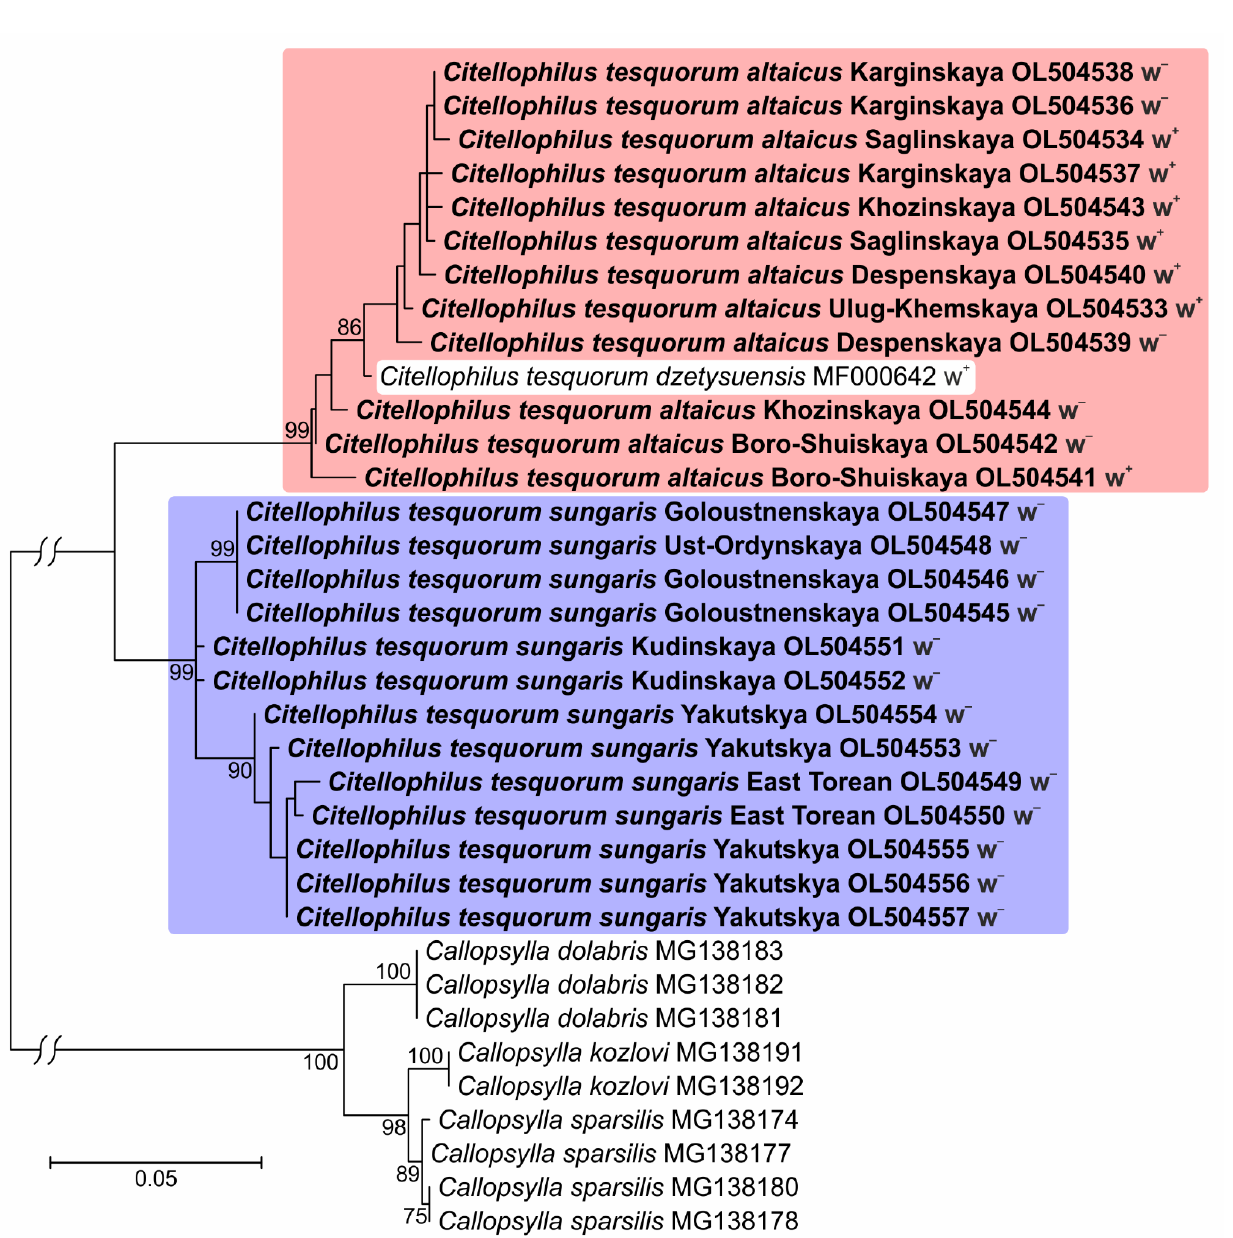
Figure 3. ML-phylogenetic tree of Citellophilus tesquorum altaicus, C. t. sungaris, C. t. dzetysuensis, and Calopsylla spp. mtDNA based on 587 bp of COI sequences (isolates included in this study are shown in bold). GenBank accession numbers, name of flea populations, Wolbachia -infection status (w + = infected; w − = uninfected) and bootstrap values (1000 iterations) greater than 70 are provided. To estimate the differentiation between subspecies according to nuclear genes, we sequenced the ITS1 and ITS2 and located 5.8S rRNA locus between them. As with the mtDNA variation analysis, we aimed to obtain sequences from all populations. However, ITS1 and ITS2 variation was very low, so we sequenced only 19 samples. Despite the low variation, the observed polymorphism subdivided the C. t. altaicus and C. t. sungaris sam- ples. The length of the nuclear sequences was in the range of 1999 to 2001 bp. Five sites were characterised by an ambiguous signal that could be explained by errors in sequenc- ing or by heterozygosity, so they were excluded from the analysis. Three isolates of C. t. altaicus and three of C. t. dzetysuensis were retrieved from the GenBank and added to the